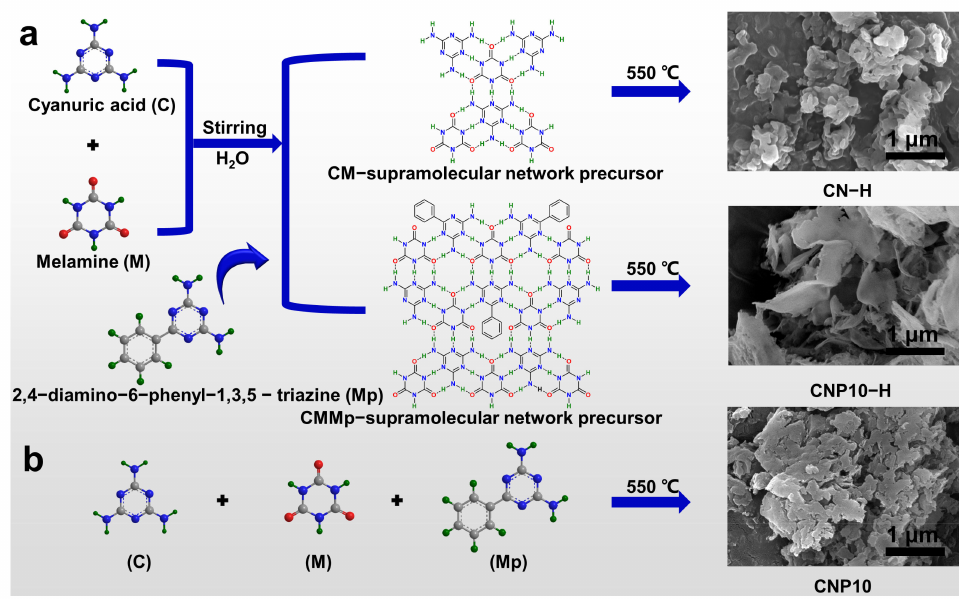
Figure 1. Schematic illustration of the preparation of ( a ) CN-H and CNP10-H nanosheet. ( b ) CNP10 obtained by directly